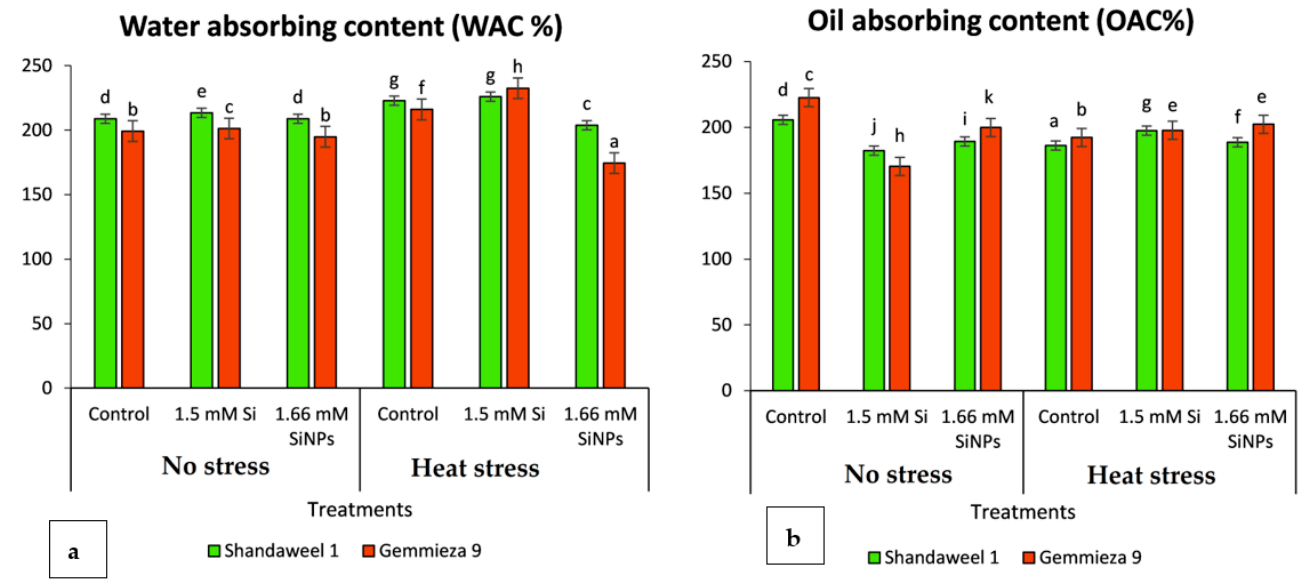
Figure 2. Effects of silicon and nanosilicon on ( a ) water absorption and ( b ) oil absorption contents of flour of two wheat cultivars cv. Shandaweel 1 and cv. Gemmeiza 9 at normal and late seasons. Each value is the main of three different replicates ± SE. Columns with different letters are significantly different at p < 0.05.